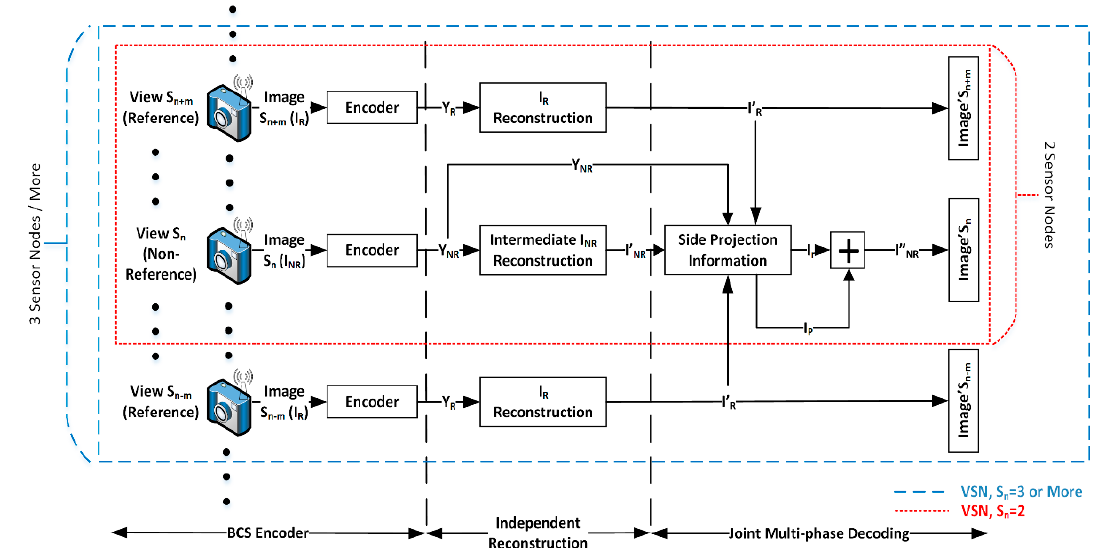
Figure 9. Overview of the joint multiphase decoding (JMD) scheme.